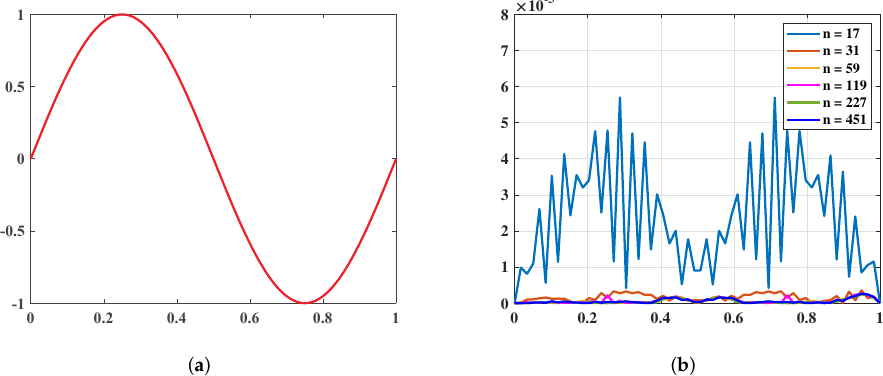
Figure 2. Comparison of the absolute error between the numerical and analytical solutions after each knot refinement. ( a ) Analytical solution. ( b ) Absolute